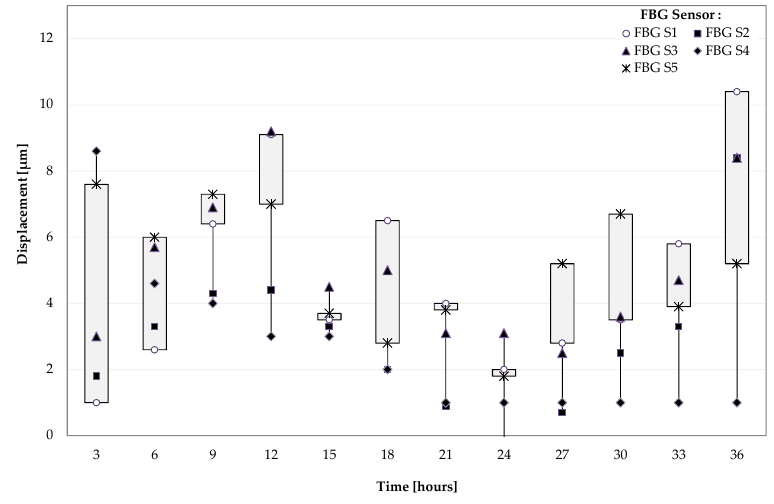
Figure 8. Variations measured by FBG sensors arranged over 36 h experimental tests.